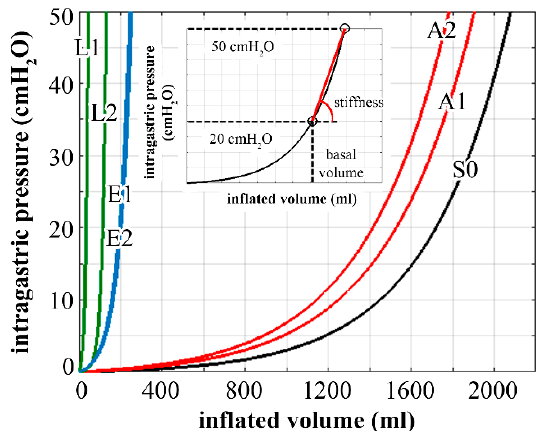
Figure 4. Computational analysis of stomach inflation: pressure–volume behavior of physiological stomach (S0), and postsurgical stomach after laparoscopic adjustable gastric banding (A1, A2), laparoscopic sleeve gastrectomy (L1, L2), and endoscopic sleeve gastroplasty (E1, E2). The subplot reports the procedure for the calculation of stomach basal volume and stiffness.